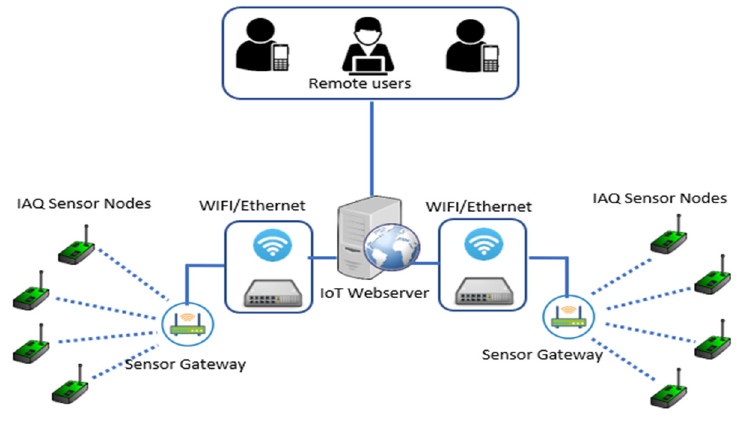
Figure 3. IAQ monitoring from various locations. Adapted from Ref. [28]. 2018, the authors.